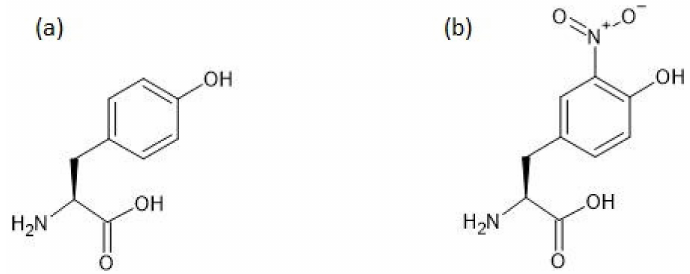
Figure 1. The chemical structures of tyrosine ( a ) and 3-nitrotyrosine ( b